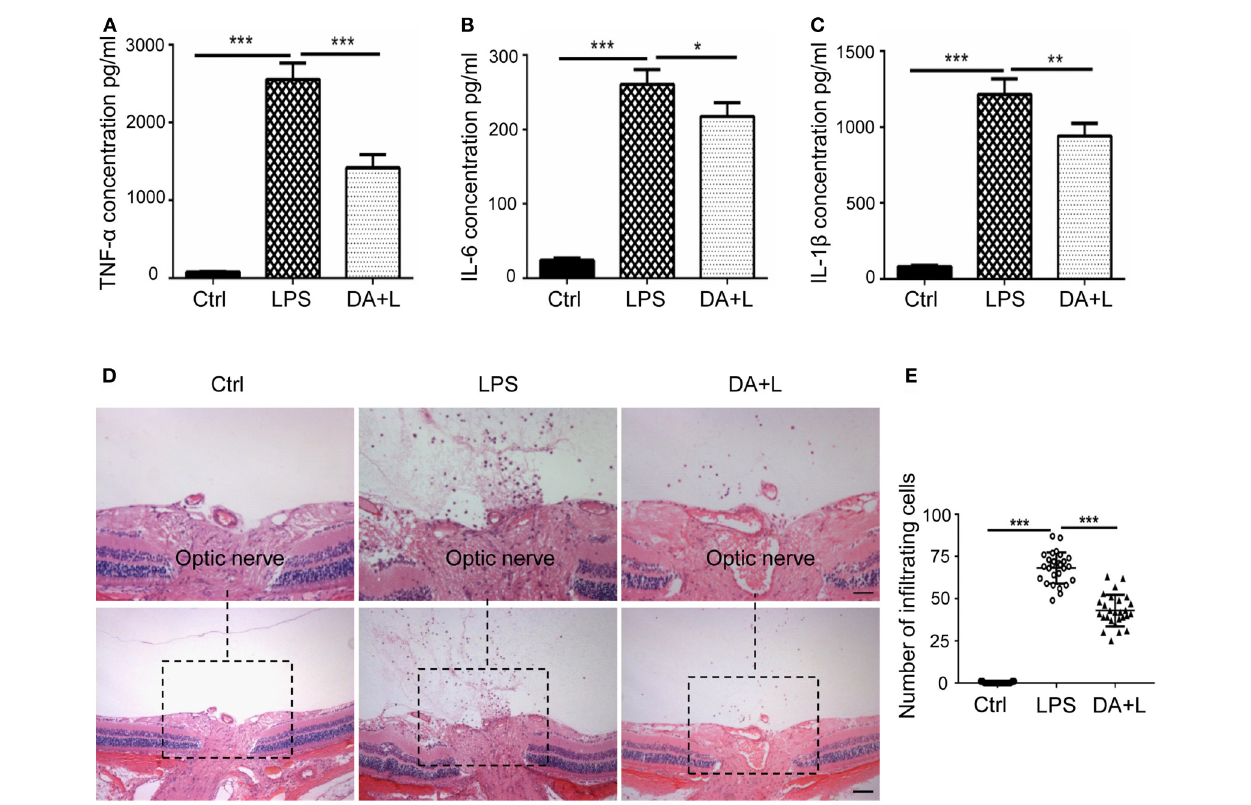
FIGURE 6 | Notch1 signaling blockade reduced the production of inflammatory cytokines and the number of inflammatory cells in EIU rat eyes. (A–C) ELISA data showed that the concentrations of TNF- α (A) , IL-6 (B), and IL-1 β (C) were significantly increased after LPS stimulation in vitreous humor compared with the control. DAPT treatment reduced the production of TNF- α , IL-6, and IL-1 β in vivo . (D) H&E staining showed that DAPT treatment markedly reduced the number of inflammatory infiltrating cells in vitreous cavity induced by LPS injection. (E) The dot plots of infiltrating cells. Total 27 retinal images in each group were used for statistical analysis. * p < 0.05, ** p < 0.01, and *** p < 0.001 (one-way ANOVA). Scale bar, 100 µ m. Ctrl, Control; DA + L, DAPT +